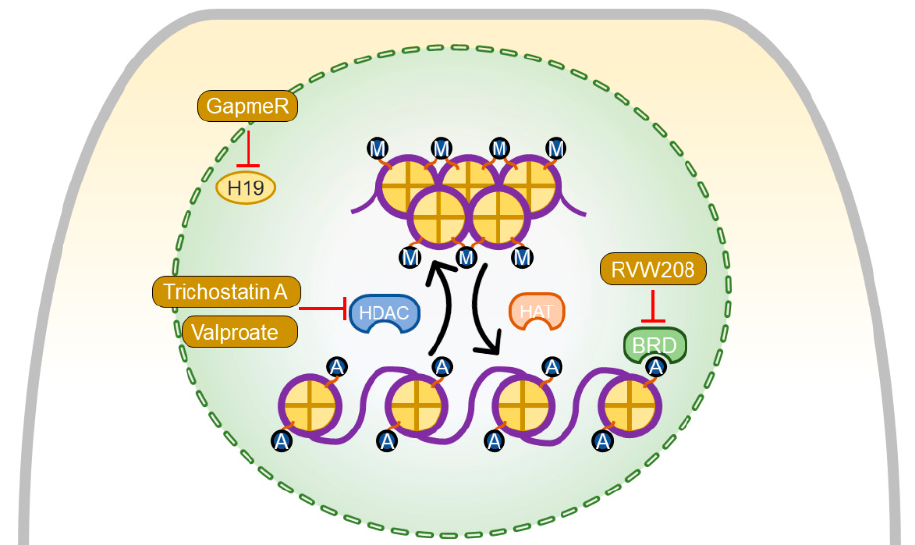
Figure 6. Mechanisms of agents improving epigenetic alterations in pulmonary artery banding (PAB)-induced right ventricular (RV) remodeling. Trichostatin A and valproate target histone deacetylases (HDACs), which remove acetyl groups from lysine residues of histone proteins. RVW208 is an inhibitor of bromodomain-containing protein 4 (BRD4), which is an epigenetic reader that recognizes histone proteins and acts as a transcriptional regulator of various genes. GapmeR, a site-specific antisense oligonucleotide, suppresses the expression of long noncoding RNA H19. All these agents mediate the improvement of RV function and promote its adaptation to pressure